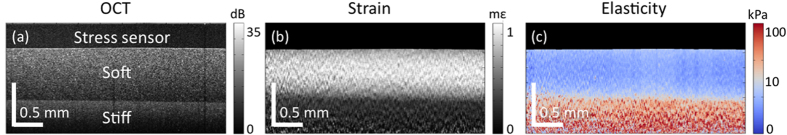
Depth-resolved quantitative micro-elastography of a bilayer phantom. (a) OCT B-scan after preload, (b) strain in the sample due to micrometre-scale actuation, and (c) quantitative micro-elastogram.